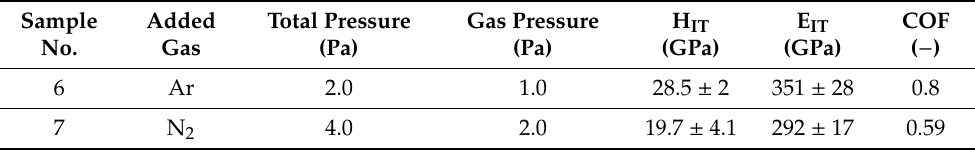
Table 2. Deposition specifications and mechanical properties of WC / C PECVD coatings deposited with added